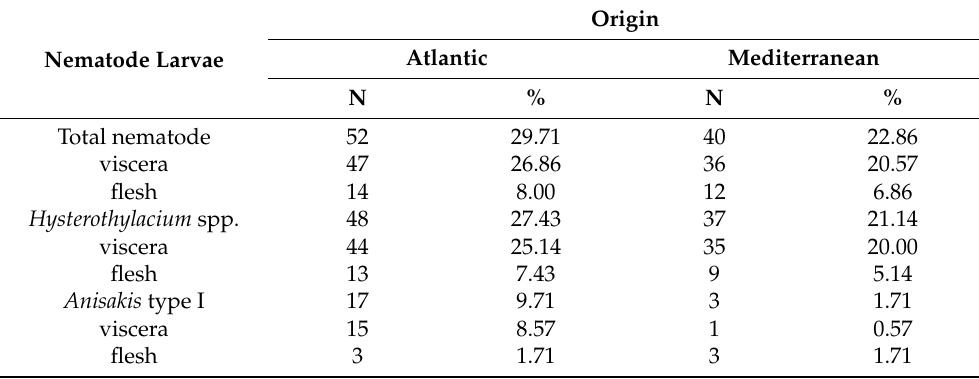
Table 2. Number (N) and prevalence (%) of sardines parasitized by nematode larvae according to the origin of catch.